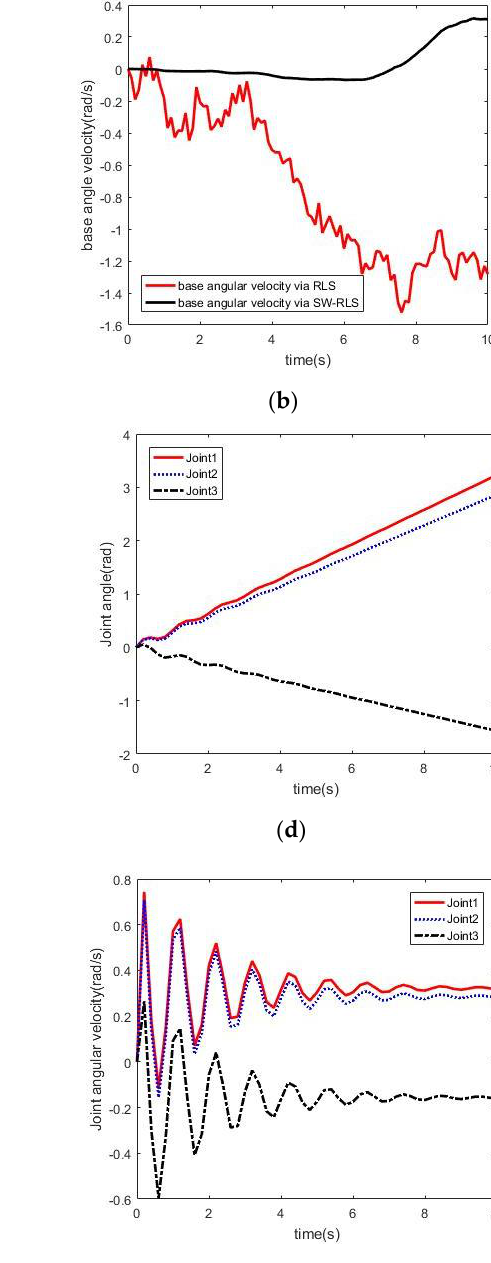
Figure 9. The diagram of the experimental system.